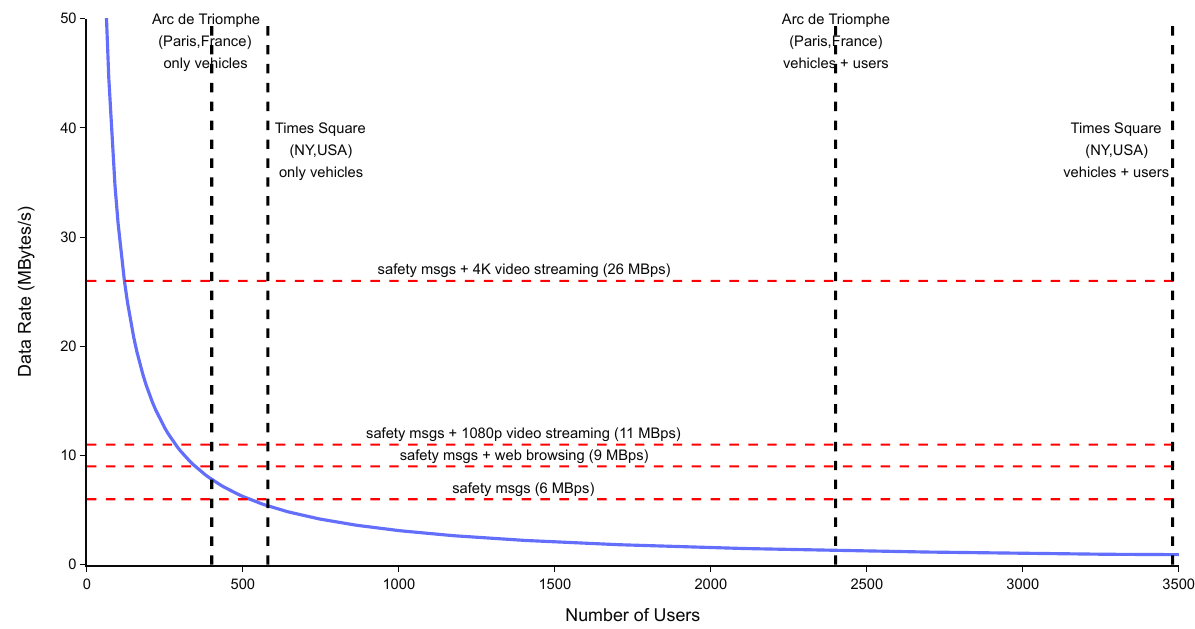
Figure 3. 5G data rates vs. number of vehicles inside the base